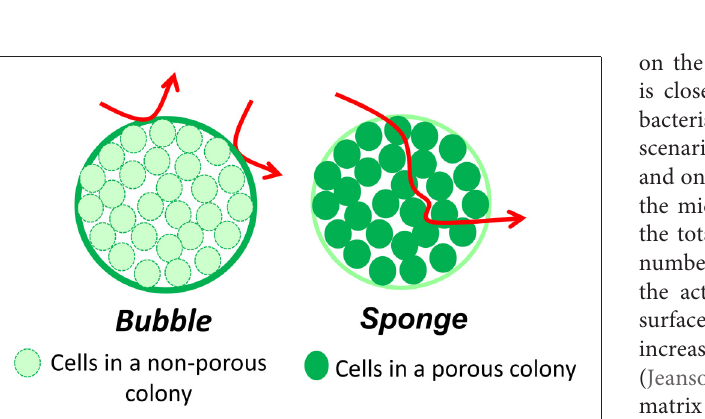
FIGURE 11 | Schematic representations of the two concepts of interactions between the colony and the matrix; arrows show the diffusing